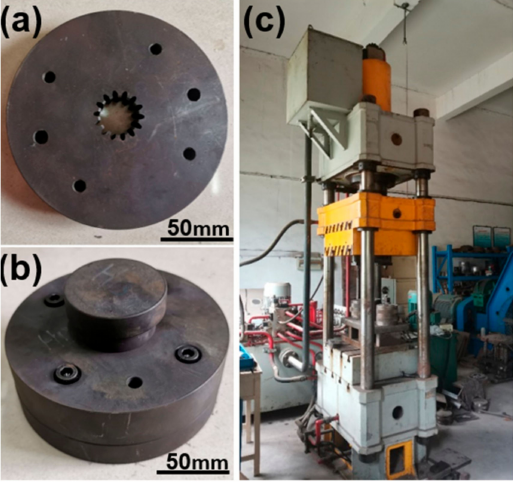
Figure 3. Experimental equipment: ( a ) toothed die, ( b ) forging die, ( c ) 160T hydraulic